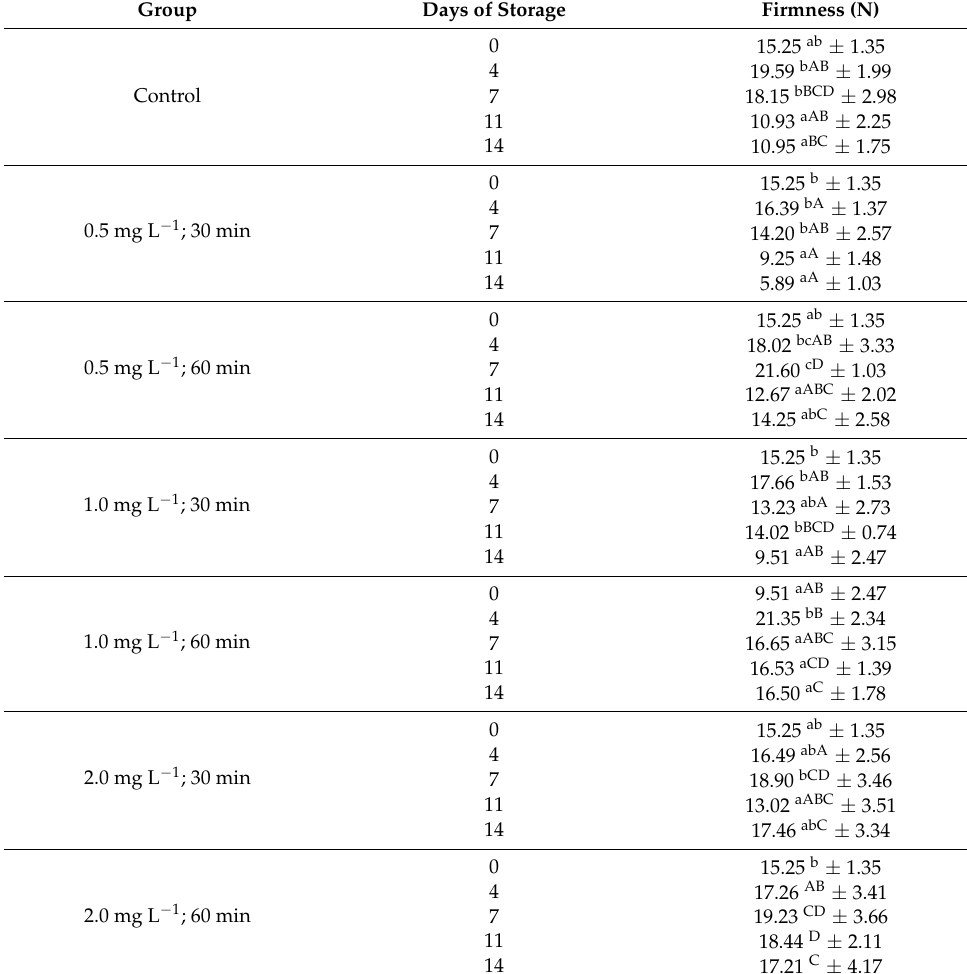
Table 5. Impact of ozone dose, time of ozonization, and storage time on firmness (N) of Agaricus bisporus measured on 0, 4, 7, 11, and 14 days of storage at 2 ◦ C. Group Days of